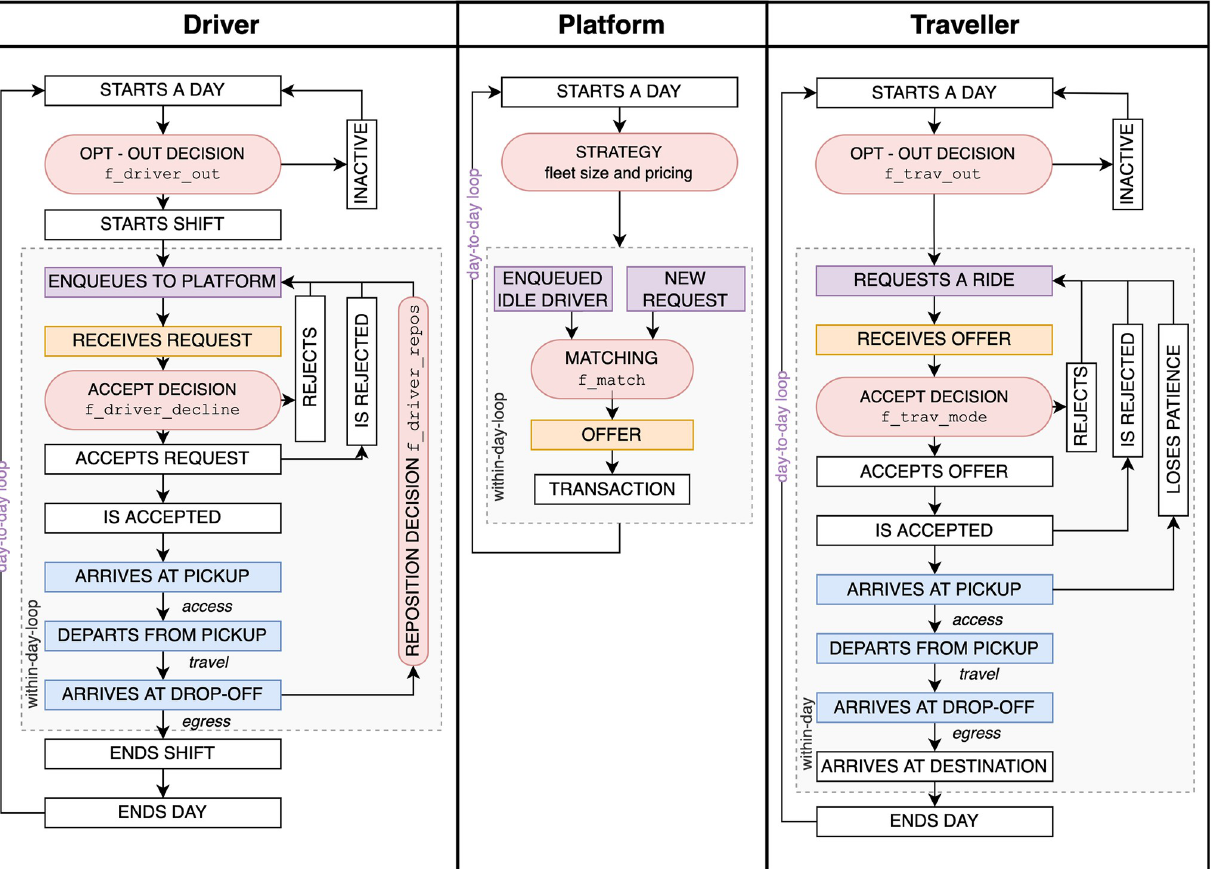
Fig 3. Routines of the three kinds of agents in MaaSSim. Boxes in violet denote an interaction with the platform, orange displays matching between drivers and travellers, and blue refers to the joint part where a traveller is transported by the driver. Places where agents make a decision are marked with red rounded boxes and their decision protocols can be replaced by user-defined python